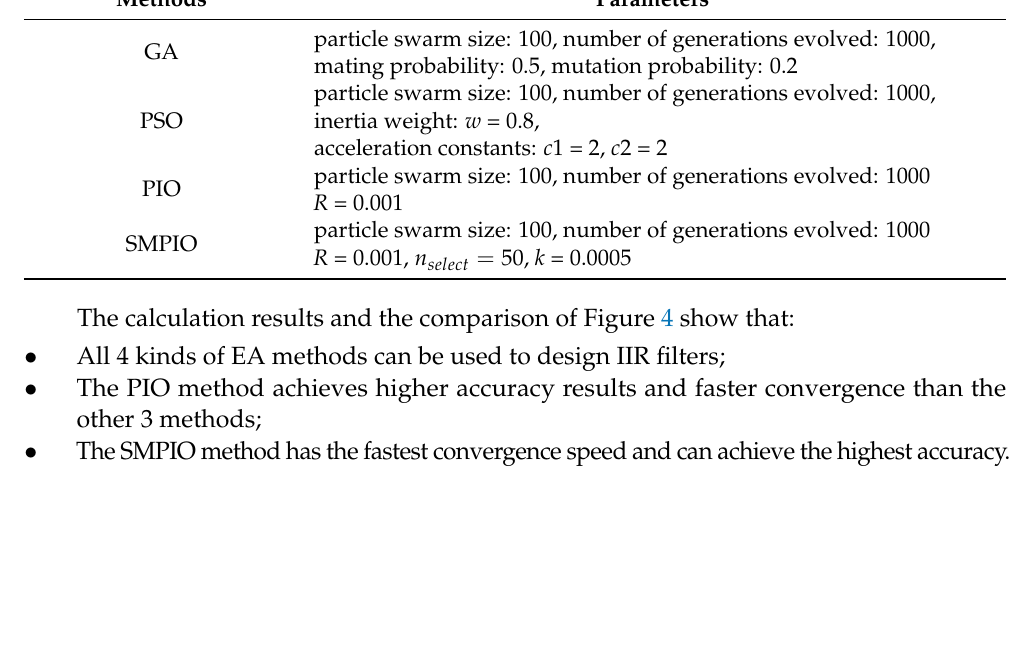
Table 2. Evolutionary algorithm methods and the parameters.